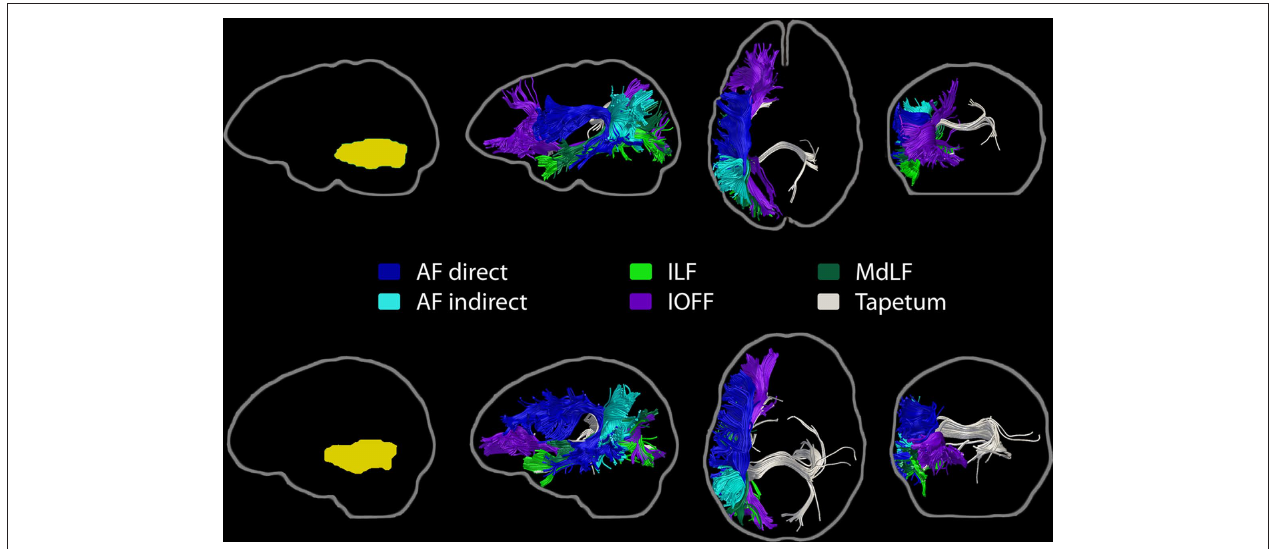
the fiber bundles involved. The direct and indirect segments of the arcuate fasciculus, the inferior occipito-frontal fasciculus, the middle longitudinal fasciculus, the inferior longitudinal fasciculus, and transcallosal projections, consistent with the tapetum, are